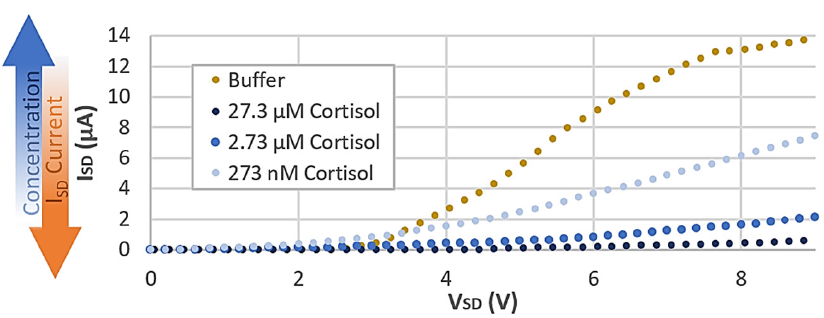
Figure 7. Reproduced previously published data [5] showing increasing output current under the same conditions for decreasing cortisol concentration solutions.